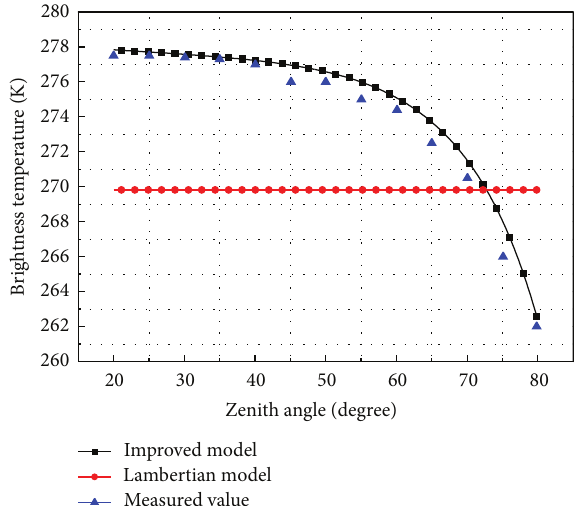
Figure 6: Comparison of the three